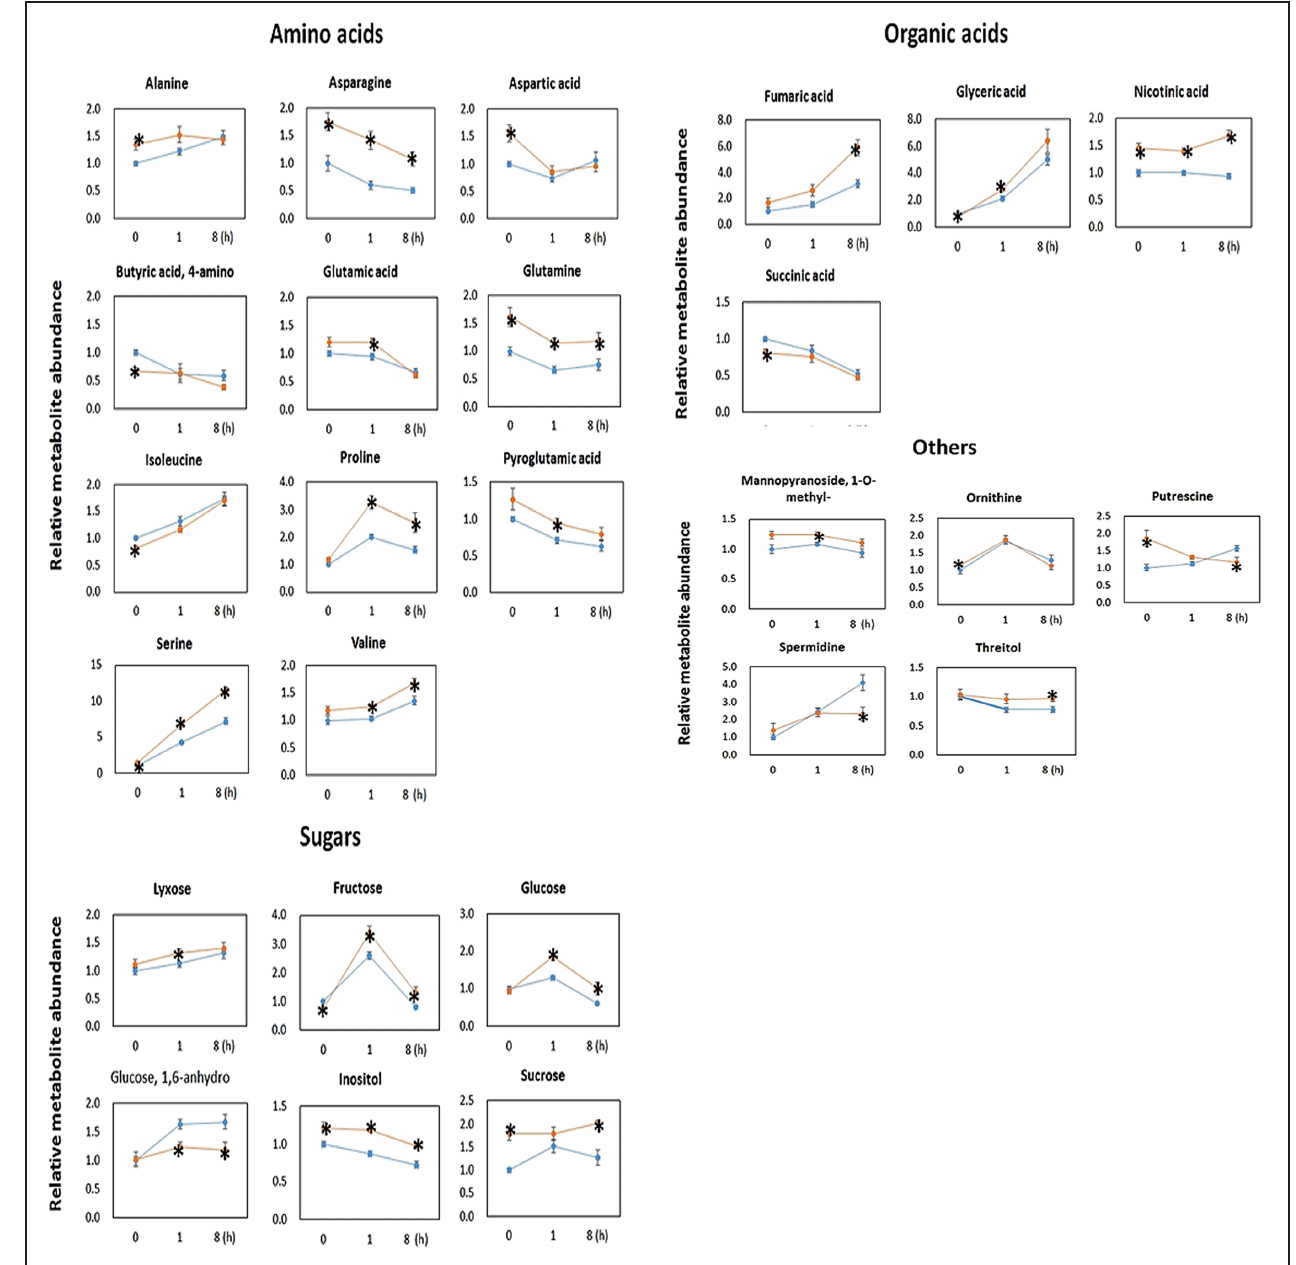
FIGURE 5 | Metabolomic data of 20-days-old Arabidopsis leaves collected at t = 0, 1, and 8 h after illumination. Metabolites were measured through gas chromatography–mass spectrometry (GC–MS). The GC–MS data are normalized with the values obtained for ribitol (internal standard) and the FW used for the extraction ( ∼ 50 mg). Data are normalized to the mean response calculated for t = 0 h of WT. Values are presented as the mean ± SE of six biological determinations. Asterisks indicates values significantly different in OE line (orange) compared with WT line (blue) at each time point ( t = 0, 1, and 8 h), respectively, as calculated by t -test (increase and decrease) with P -value <